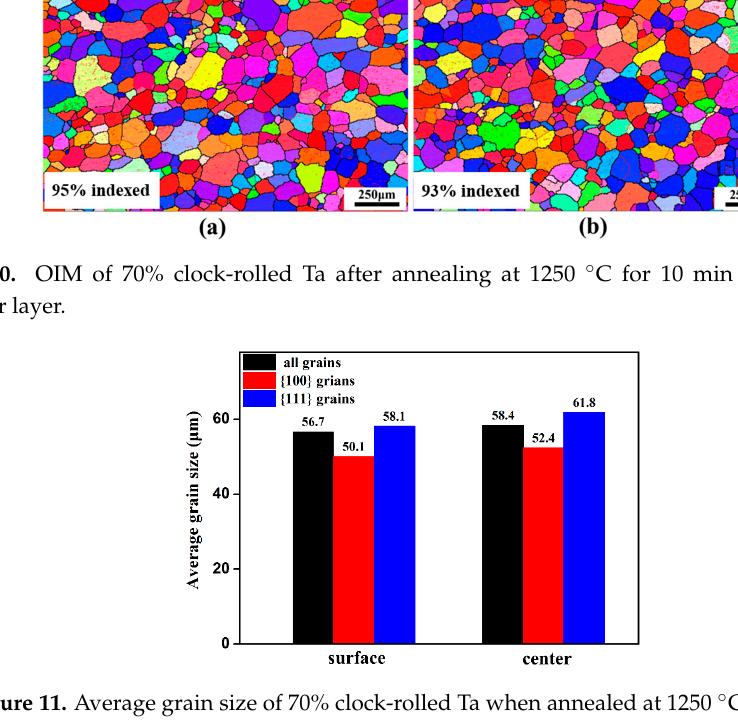
Figure 12. The ODF sections ( φ 2 = 45°) of 70% clock-rolled Ta plates along the thickness after annealing at 1250 °C for 10 min: ( a ) Surface layer, ( b ) center layer. 4. Discussion 4.1. Initial Texture and Stored Energy Gradient After eight passes of clock rolling, a plate (70% deformation) with a thickness of 6 mm was obtained. It can be seen from Figure 2 that the {111} texture intensity in the center layer is greatly improved with respect to the surface layer and the {100} texture intensity is decreased, indicating that the strong texture gradient exists along the thickness. The severe texture gradient is mainly caused by the difference in the local strain direction and strain rate caused by the uneven shearing force along the plate thickness during the deformation process [19–21]. It is well known that the rolling deformation in the center of sheets is characterized by a plane-strain state [21,22]. The friction and the roll-gap geometry do not affect the texture evolution in the center layer. Therefore, the initial orientation rotates toward a stable orientation during cold rolling, leading to an increase of γ fiber in the center layer. However, the shear deformation produced by the friction between the roll and the sample contact surface is maximum. The change of rolling direction in every pass necessarily causes a variation of shearing direction, leading to the occurrence of more random orientation in the surface layer. Besides, for metals with high stacking fault energy, such as aluminum, niobium, tantalum and their alloys, the texture gradient through the thickness is easily formed during cold rolling, but is not easy to be formed in metals with low stacking fault energy, such as brass [19,21,23]. Quantitative evaluation of the stored energy in the interior of grains with different orientations along the thickness by XLPA revealed that the stored energy in the center layer was significantly higher than that of the surface layer, and the stored energy of the {111} grains is much higher than